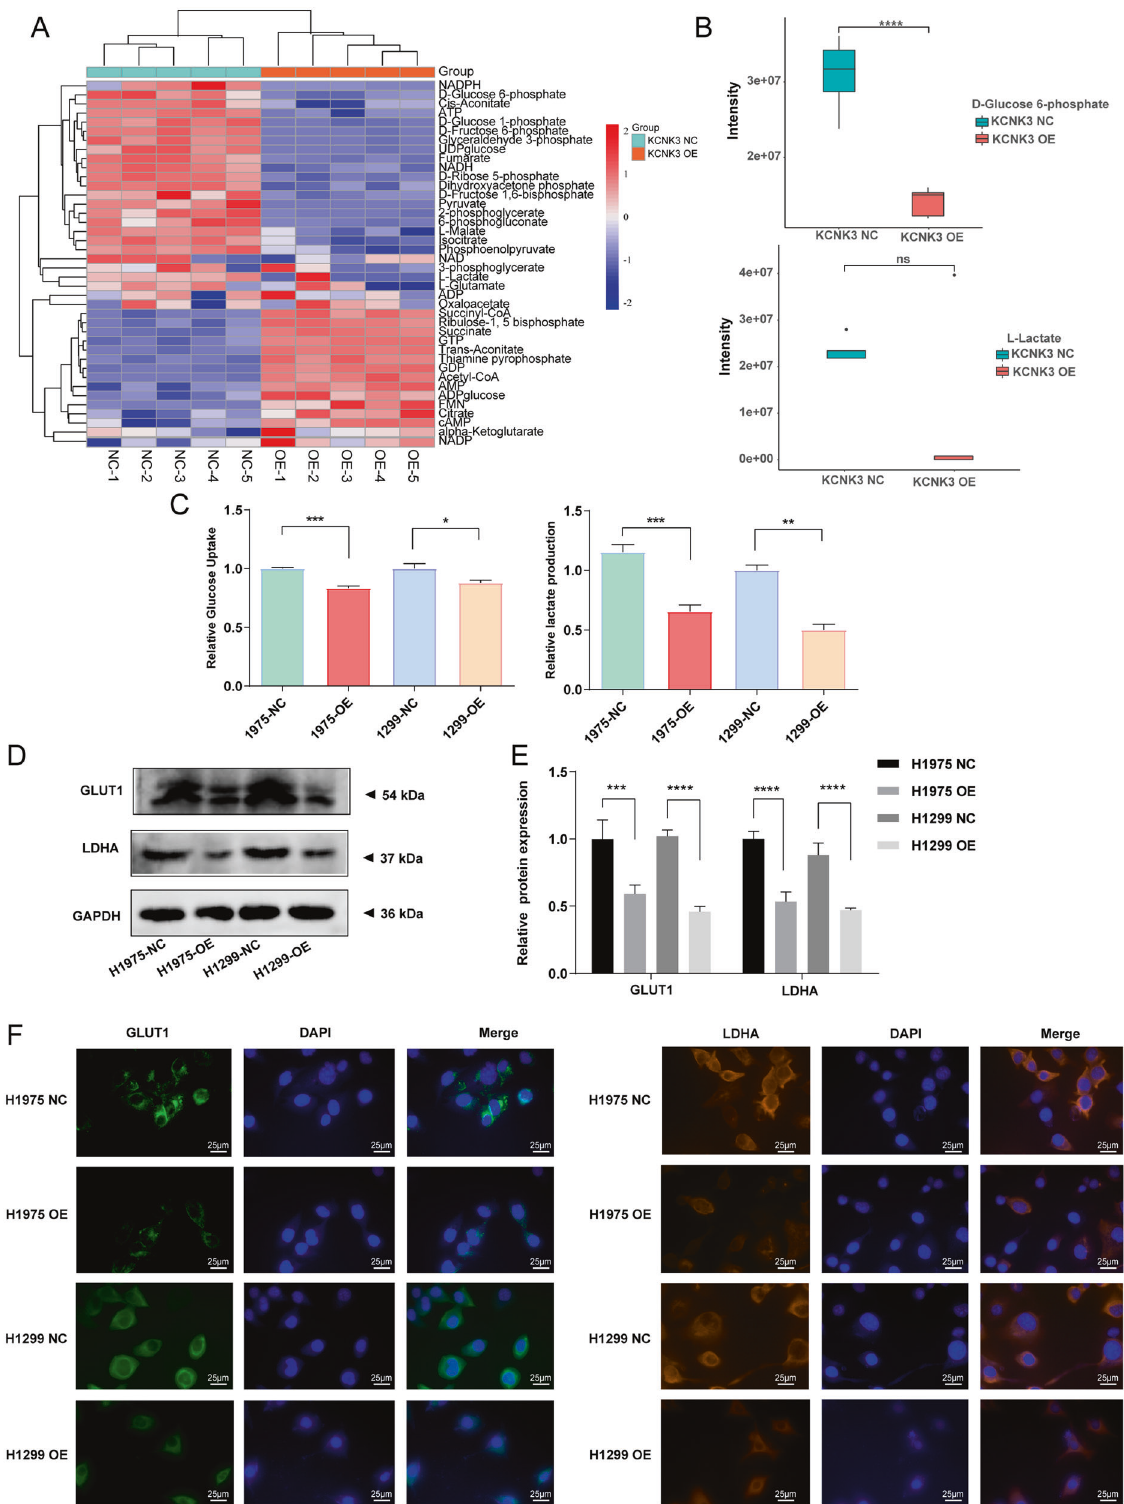
Fig. 3 KCNK3 was involved in the process of glucose metabolism in LUAD cells. A Heatmap of energy metabolites measured by target metabolomics analysis in KCNK3 overexpression groups and control groups. B Metabolic levels of D-glucose 6-phosphate and L-lactate detected by target metabolomics analysis. C Relative glucose uptake and lactate production were measured in KCNK3-overexpressed or control LUAD cells. D , E Western blot analysis of GLUT1 and LDHA protein expressions was performed in KCNK3-overexpressed LUAD cells, with results normalized relative to the expression of GAPDH. F GLUT1 and LDHA immuno fl uorescence was detected to show the glucometabolic alteration in KCNK3-overexpressed LUAD cells, scale bar 25 µm. (NC negative control, OE overexpression. Data are presented as the mean ± SD of three independent experiments. * P < 0.05, ** P < 0.01, *** P < 0.001, **** P < 0.0001).